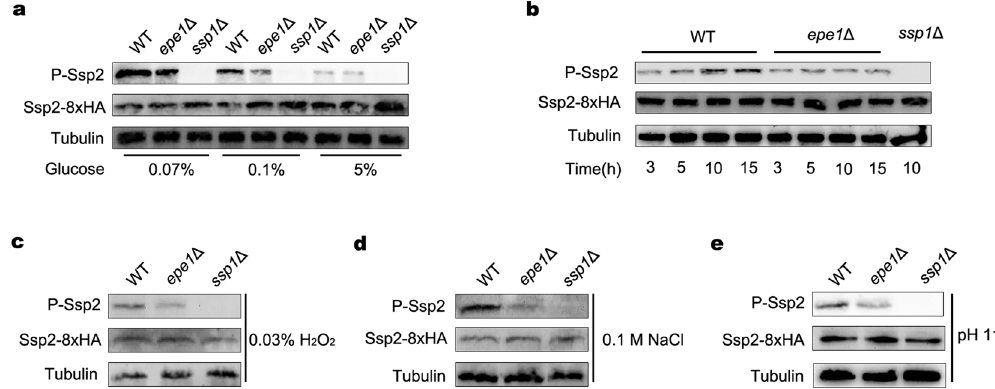
Figure 2. Deletion of epe1 + abolished induction of Ssp2 phosphorylation upon environmental stresses. ( a , c – e ) Western blot to examine the amount of phosphorylated Ssp2 (P-Ssp2) in WT, epe1 Δ , ssp1 Δ cells growing in YES containing different concentrations of glucose ( a ), 0.03% H 2 O 2 ( c ), 0.1 M NaCl ( d ) or at pH 11 ( e ). Tubulin was detected as a loading control. Cropped blots are shown for clarity. Full-size blots are